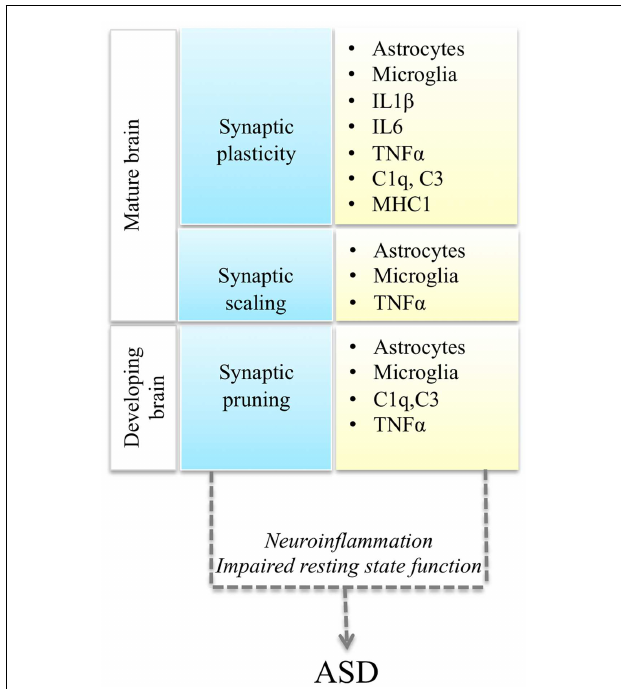
FIGURE 1 | Interactions between synaptic function and immune molecules and cells, and possible mechanisms leading toASD . Multiple aspects of synaptic function (blue boxes) are regulated by astrocytes, microglia, and immune molecules (yellow boxes). Either immune activation during neuroinflammation or impaired resting state activity of immune cells in the brain could impair synaptic function and lead to